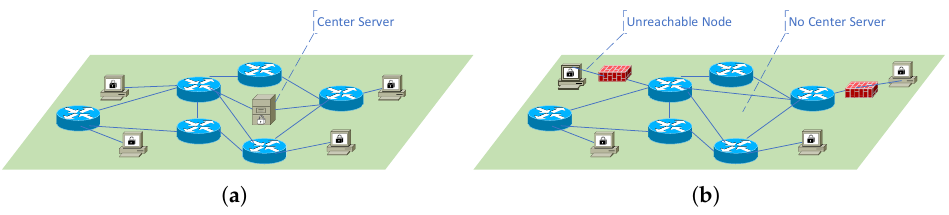
Figure 1. Two modes of network communication. ( a ) Center model. ( b ) Peer-to-peer